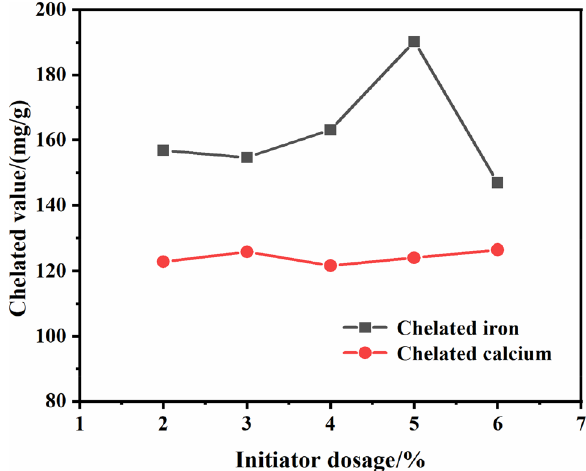
Figure 4. Effect of initiator dosage on chelated value.